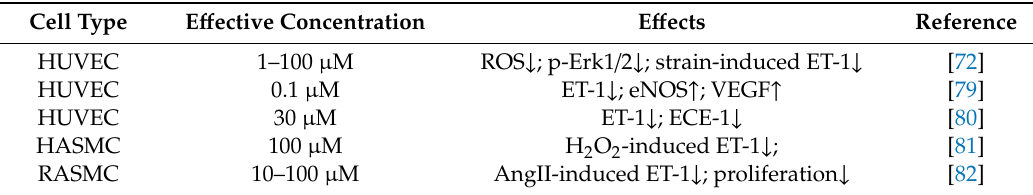
Table 3. Resveratrol reduces endothelin-1